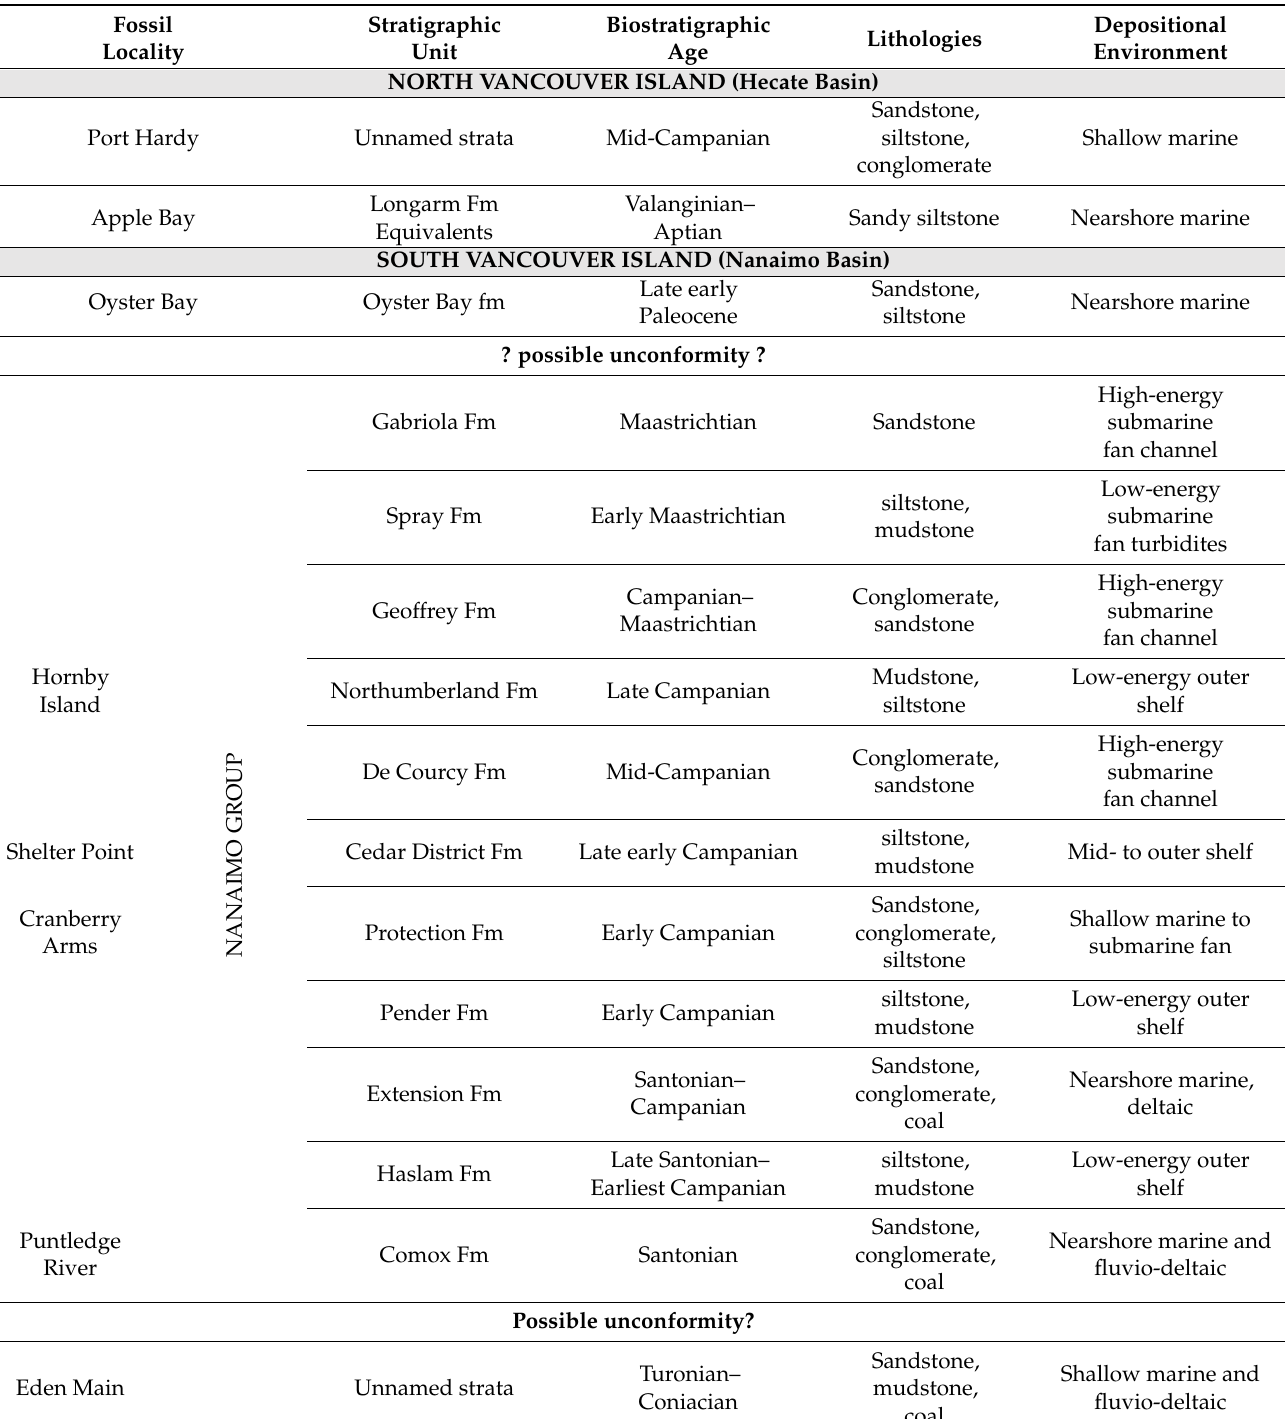
Table 1. Stratigraphy of the Vancouver Island Cretaceous and Paleocene plant fossil localities of Mustoe and Beard